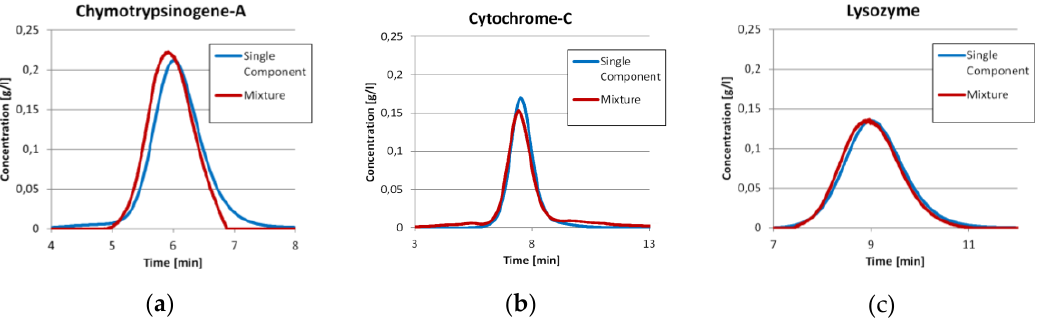
Figure 3. Comparison between the single component injection (blue line) and the deconvoluted peak (red line) of the same component in the mixture for the three proteins Chymotrypsinogene-A ( a ); Cytochrome-C ( b ) and Lysozyme ( c ). Table 1. Deviation from single component to mixture measurement.